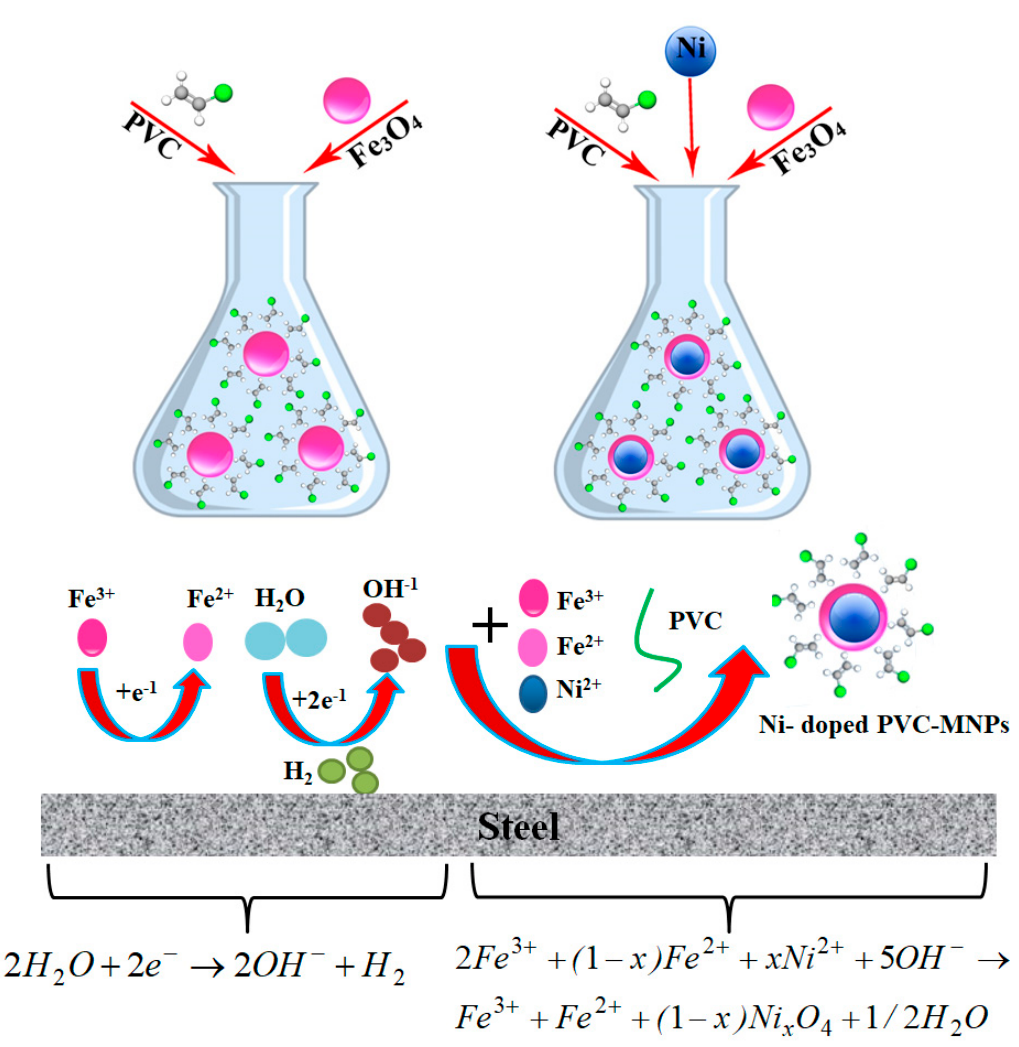
Figure 1. Surface and bulk modification of the Fe 3 O 4 nanoparticles by the polyvinyl chloride (PVC) and Ni, respectively.